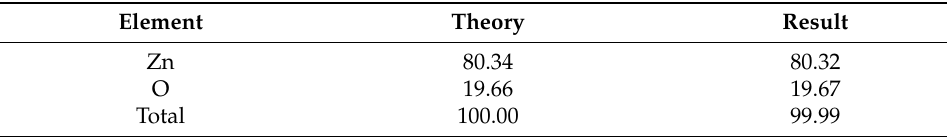
Figure 7. EDS pattern of ZnO nanorods. Table 1. Elemental analysis of the synthesized ZnO nanorods.